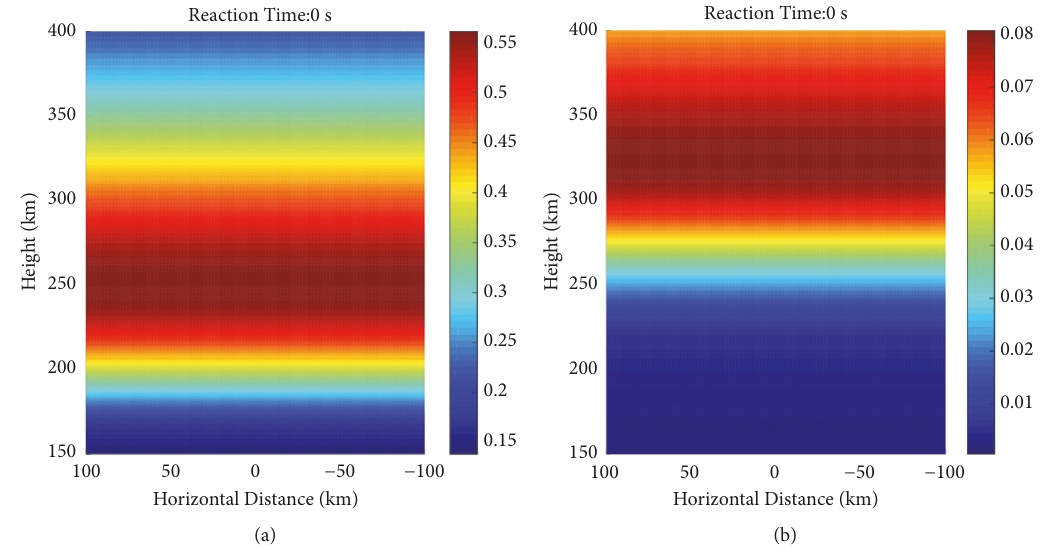
Figure 3: (a) Background ionospheric electron concentration profile during the day; (b) background ionospheric electron concentration profile during the night.